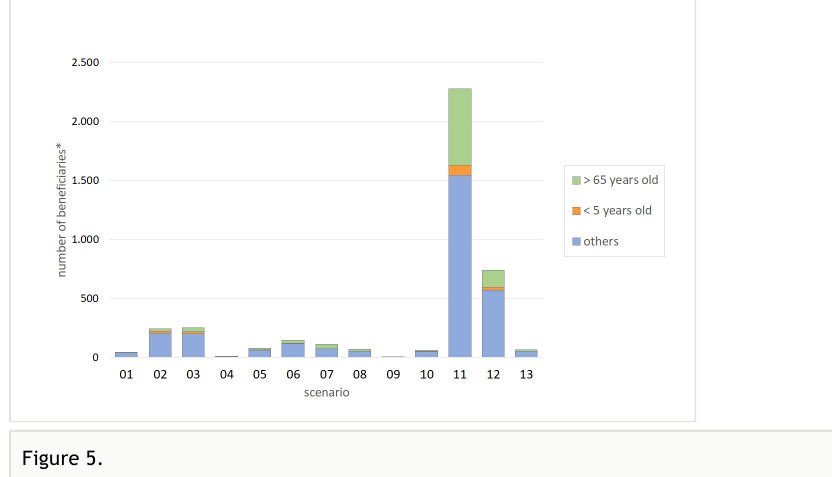
Expected bene fi ts produced by the di ff erent scenarios in terms of enhanced cooling e ff ect by urban green infrastructure: number of bene fi ciaries broken down into di ff erent vulnerability